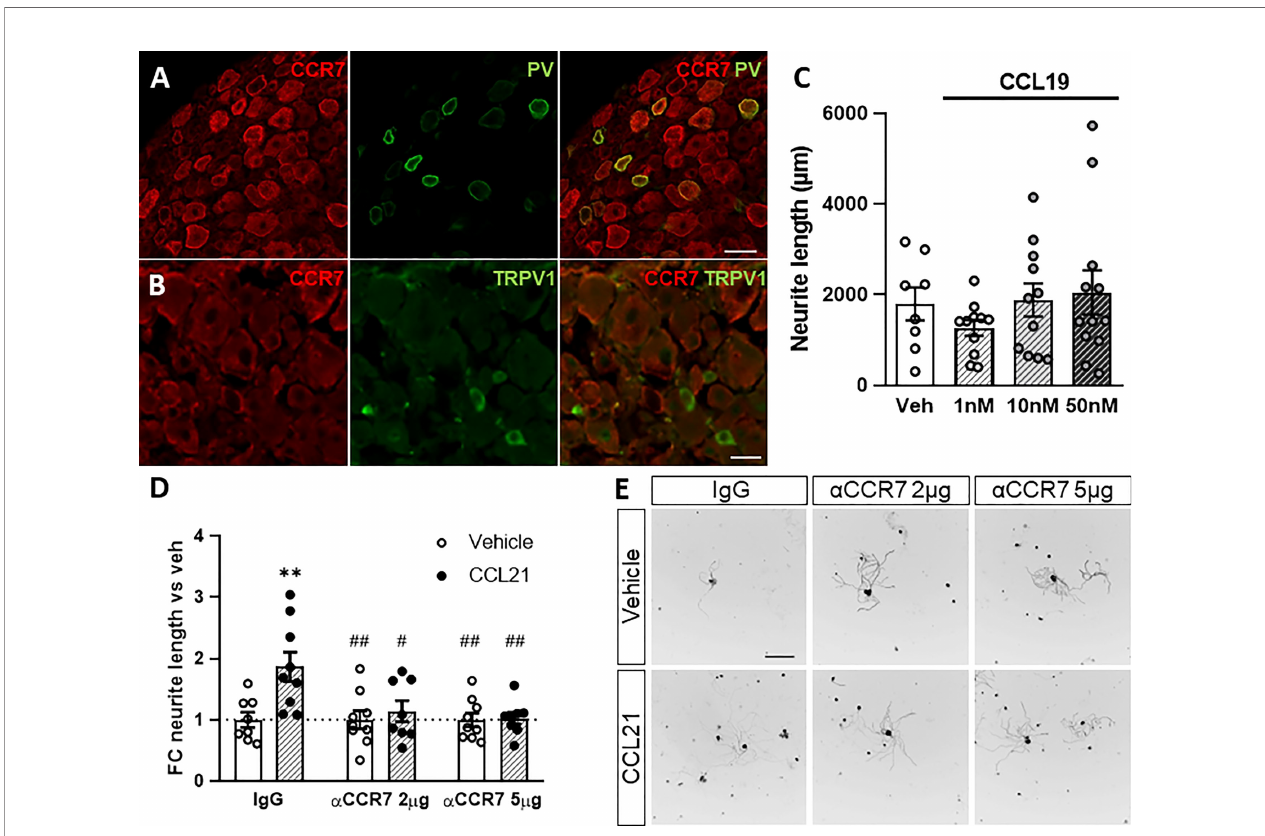
FIGURE 3 | CCR7 is required for CCL21-mediated DRG outgrowth. A-B. PV + but not TRPV1 + neurons express the canonical CCL21 receptor CCR7. Scale bar: 50 m m (A) 25 m m (B) . (C) CCL19 administration does not induce neurite outgrowth. Data are expressed as average neurite length per neuron ± s.e.m; n=8-12 images. (D) CCR7-blockade abolished the CCL21-dependent growth induction. Data are expressed as mean fold change of average neurite length per neuron vs each vehicle group ± s.e.m. Two-way ANOVA, Bonferroni ’ s post-hoc ; ** p < 0.01 (vs IgG-veh); # p < 0.05; ## p < 0.01 (vs IgG-CCL21); n=8-9 images. (E) Tuj-1 representative immunostainings after 24h in culture. Scale bar: 250 m